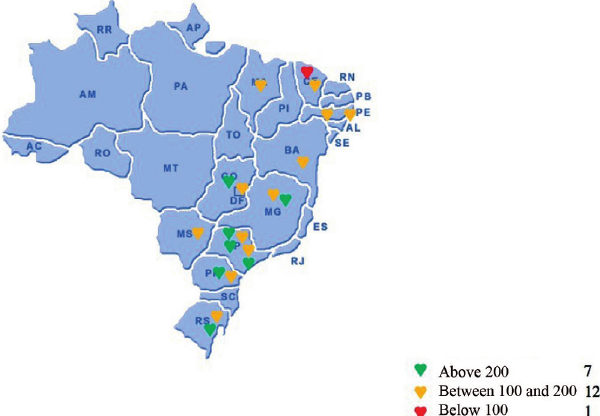
Figure 1 - Distribution of the top 20 hospitals operating patients of all age groups